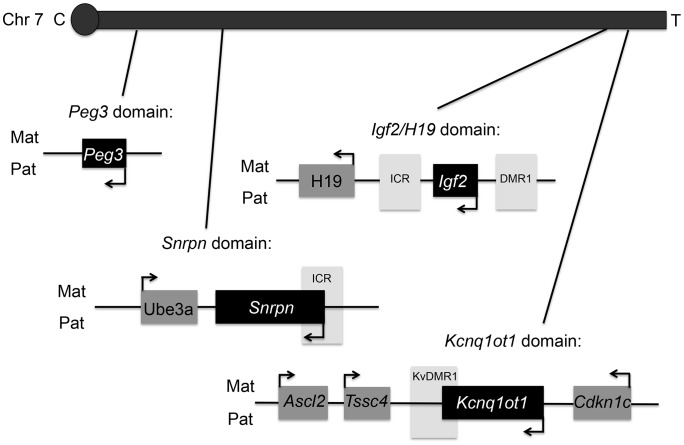
Map of mouse chromosome 7 showing imprinted domains analyzed in the current work is illustrated.Black = paternally expressed genes; dark grey = maternally expressed genes; and light grey = differentially methylated regions (DMRs). Arrows indicated direction of gene transcription. C = centromere and T = telomere. Not drawn to scale.